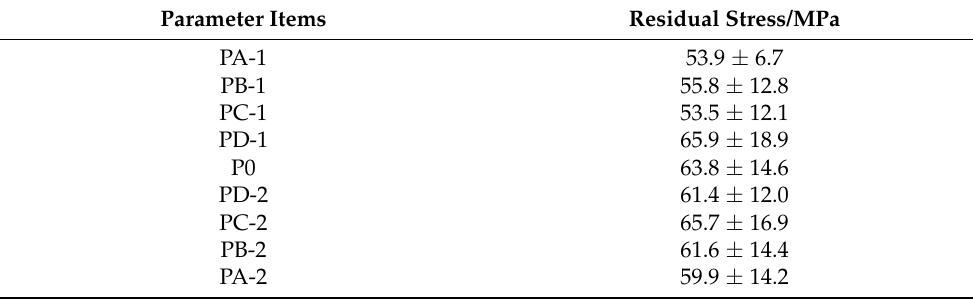
Table 3. Calculated residual stresses for nine groups of coatings.